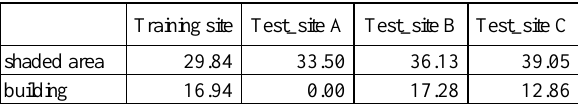
Table 2. Sample percentage of shaded and building areas over the training site and the test site